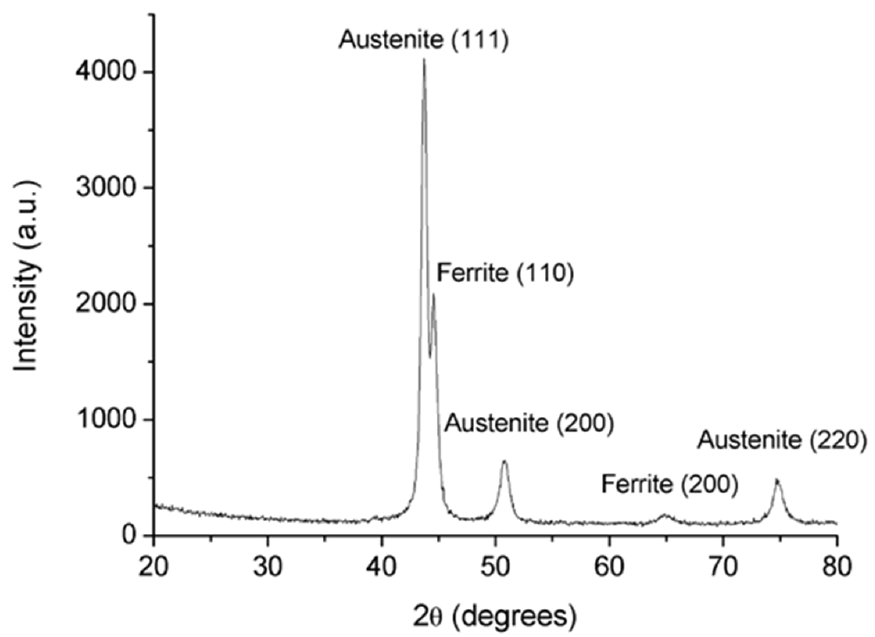
Figure 7. XRD patterns of the ME 316L stainless steel.